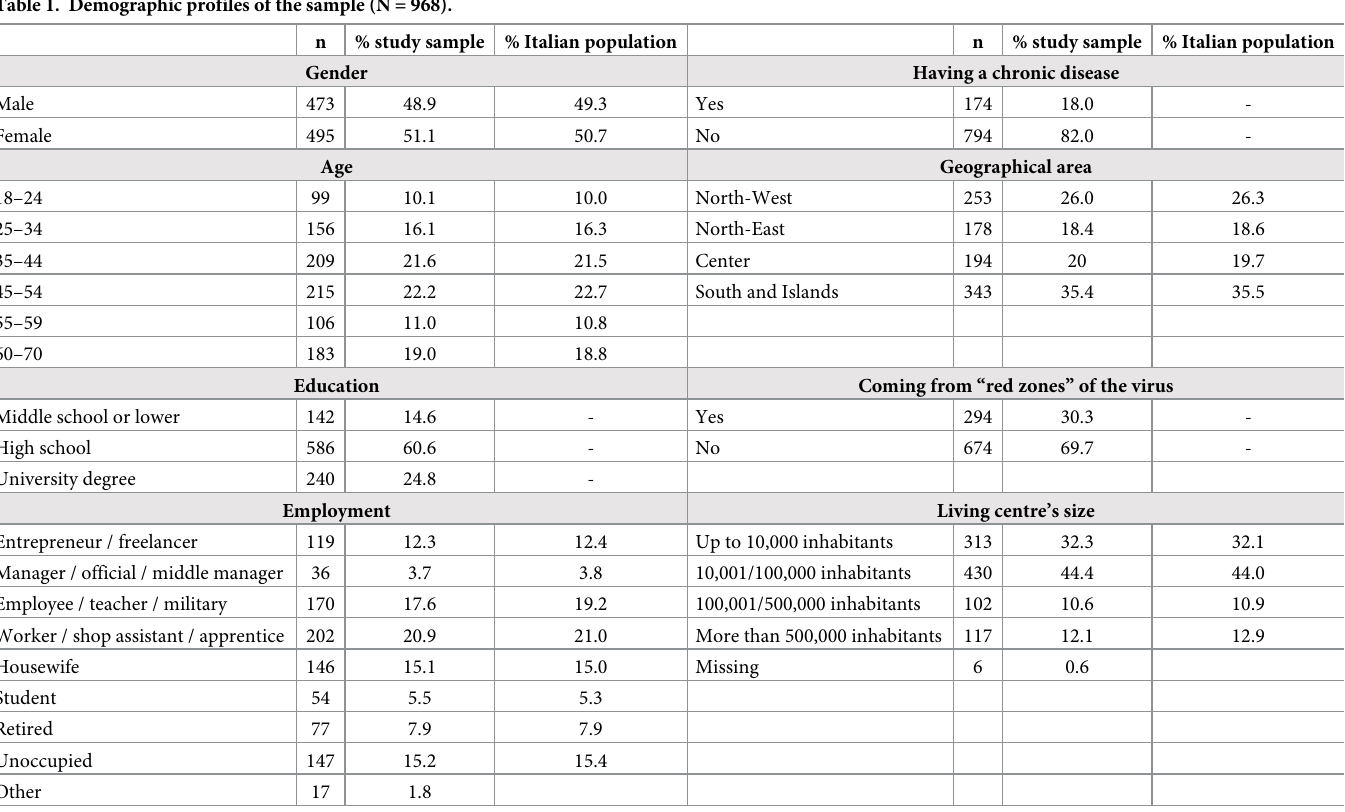
Table 1. Demographic profiles of the sample (N =